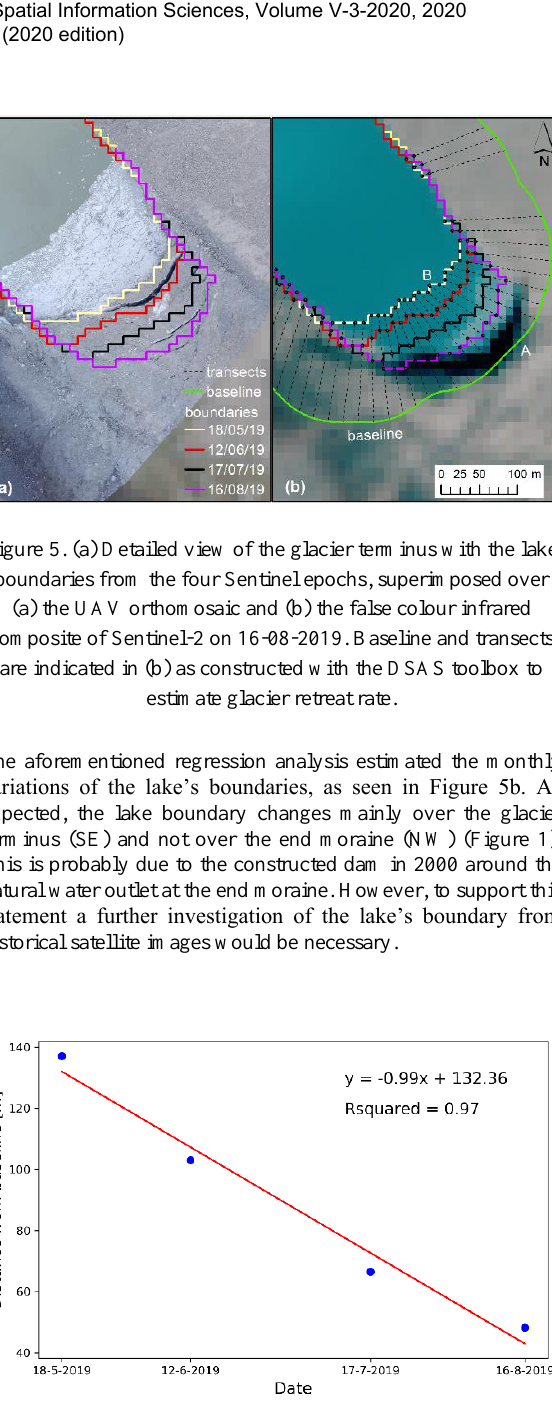
Figure 6. Regression analysis for transect AB seen in Figure 5b.